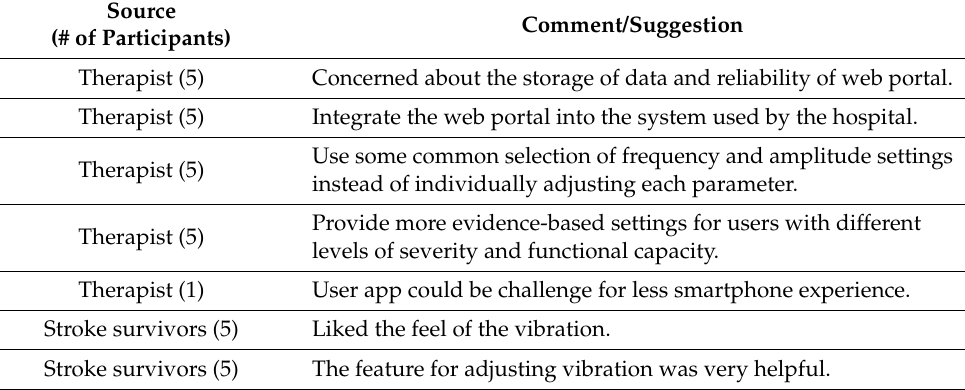
Table 2. Therapists ’ feedback on the FoVi prototype, app, and web portal (SD = Strongly disagree, D = disagree, N = neither agree nor disagree, A = agree, and SA = Strongly agree).